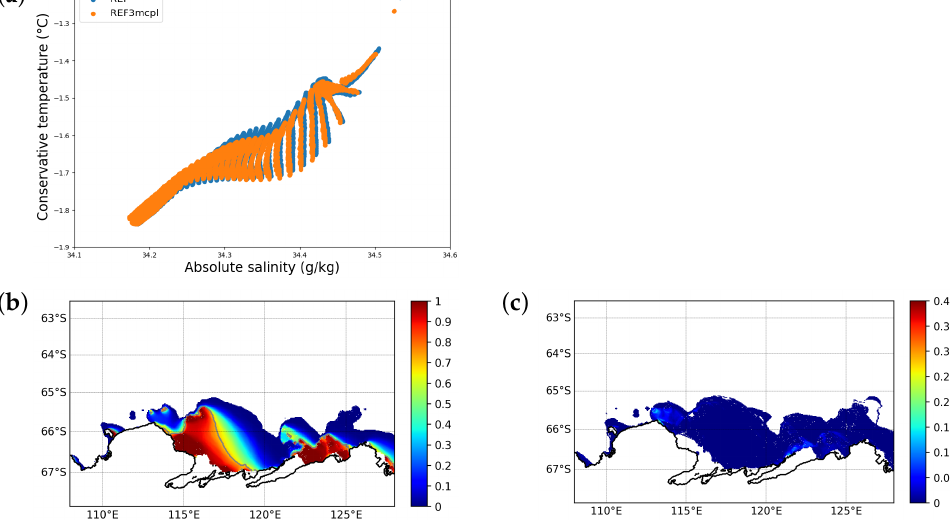
Figure 12. Temperature–salinity diagram ( a ) representing the ocean properties over the continental shelf in front of the TIS in REF3mcpl (red) and REF (blue). Fast ice frequency in REF ( b ), and fast ice frequency differences between REF3mcpl and REF ( c ). The fast ice and ocean properties are averaged over the 20-year